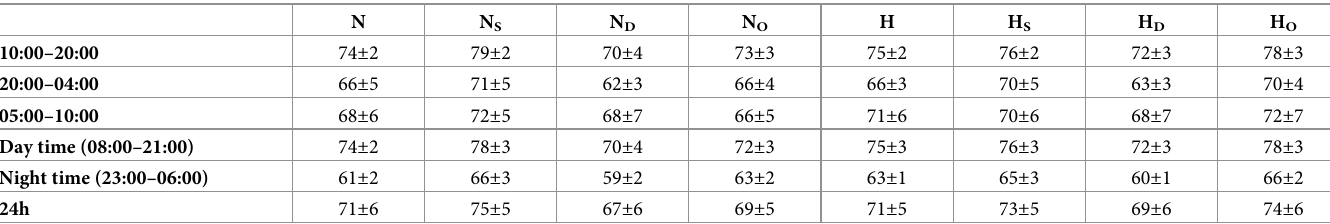
Table 3. Mean values ± 1SD of HR values (bpm) in the three periods, during day time, night time and along the 24h, for each subject group. N